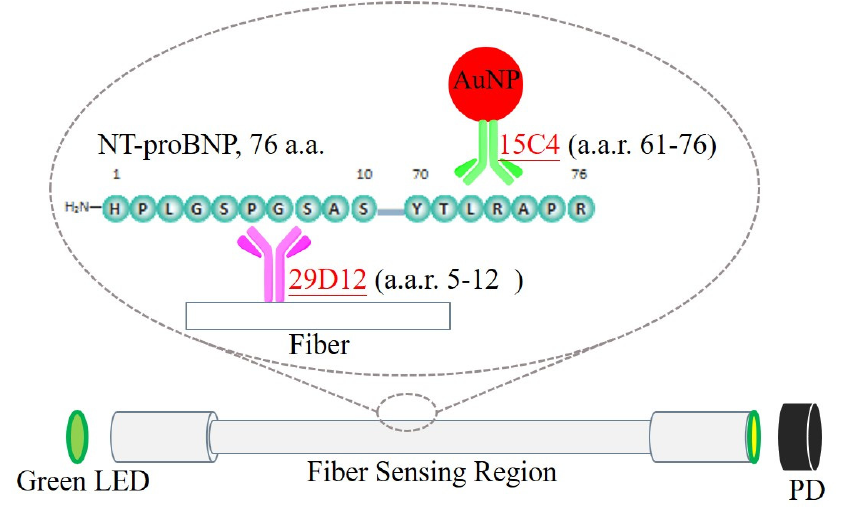
Figure 1. Schematic representation of the FONLISA strategy in the FOPPR sensing system for detection of NT-proBNP. The capture antibody (Ab C , 29D12) is immobilized on the sensing region, and the detection antibody (Ab D , 15C4) is conjugated to AuNP. When an analyte is sandwiched between the two antibodies, the green light generated from the LED (532 nm) will pass beneath the sensing region and be absorbed by AuNP to finally reach the PD.